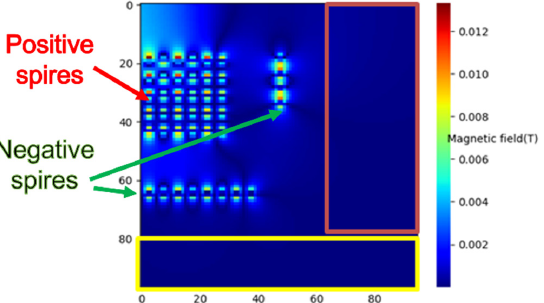
Figure 11. Transformer magnetic field mapping and test surfaces with in red, the vertical characteri-